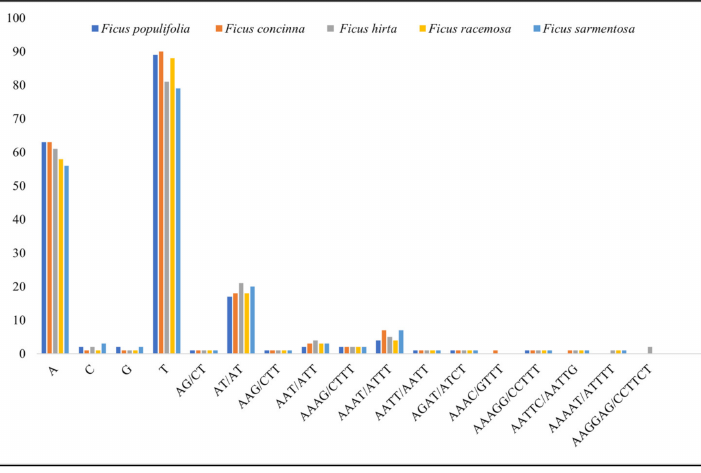
Figure 9. The frequency of microsatellite motifs in plastomes of five Ficus